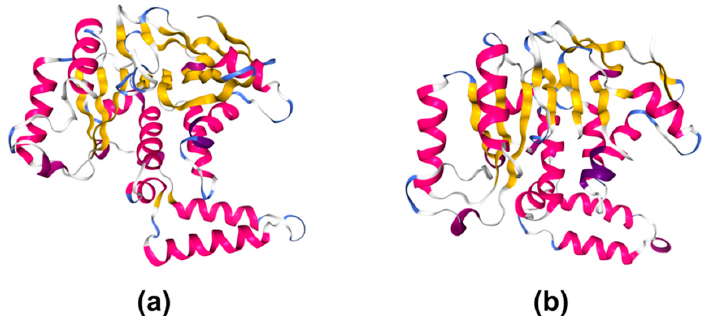
Figure 5. Structure of NleB/SseK family members. ( a ) Crystal structure of SseK3 from S. enterica serovar Typhimurium strain SL1344 (PDB ID: 6CGI) [147]; ( b ) crystal structure of NleB1 from E. coli O127:H6 (PDB ID: 6E66) [146]. Drawings created with NGL [53].